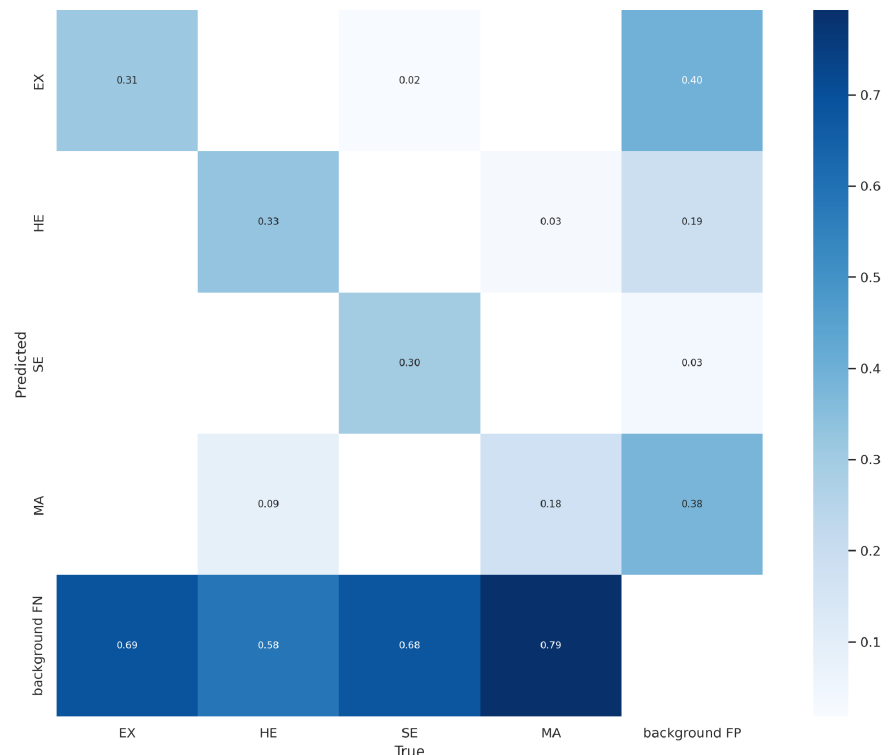
Figure 6. Confusion matrix obtained by the proposed approach with the Stochastic Gradient Descent (SGD) optimizer and Tilling during the validation step on the Dataset for Diabetic Retinopathy (DDR). EX, hard exudates; HE, hemorrhages; SE, soft exudates; MA, microaneurysms; FN, False Negative; FP, False